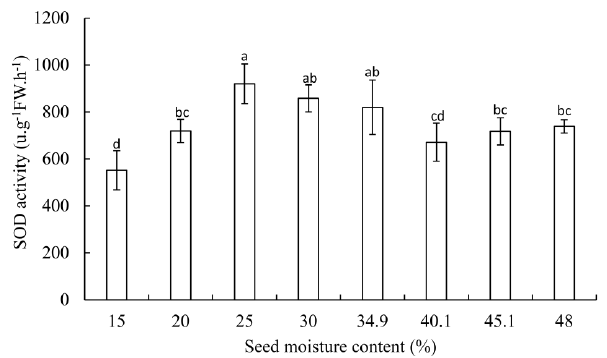
Figure 5. Changes of superoxide dismutase (SOD) activity in G. biloba seed embryos during desiccation. Data are means of three replicates ± SD, and bars labeled with the same lower-case letter do not differ significantly at the 0.05 probability level.